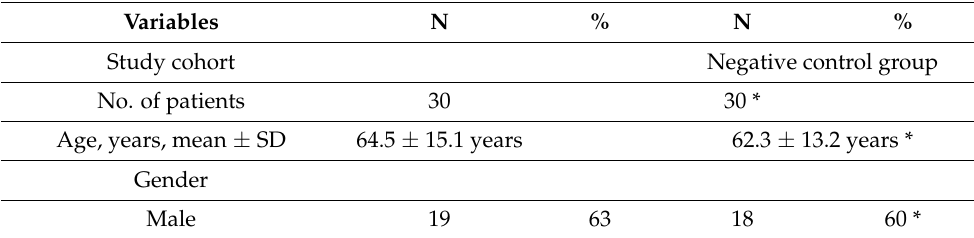
Table 1. Patient